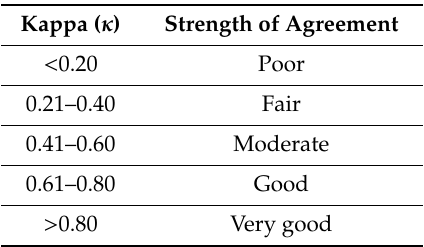
Table 2. Criteria of kappa ( κ )